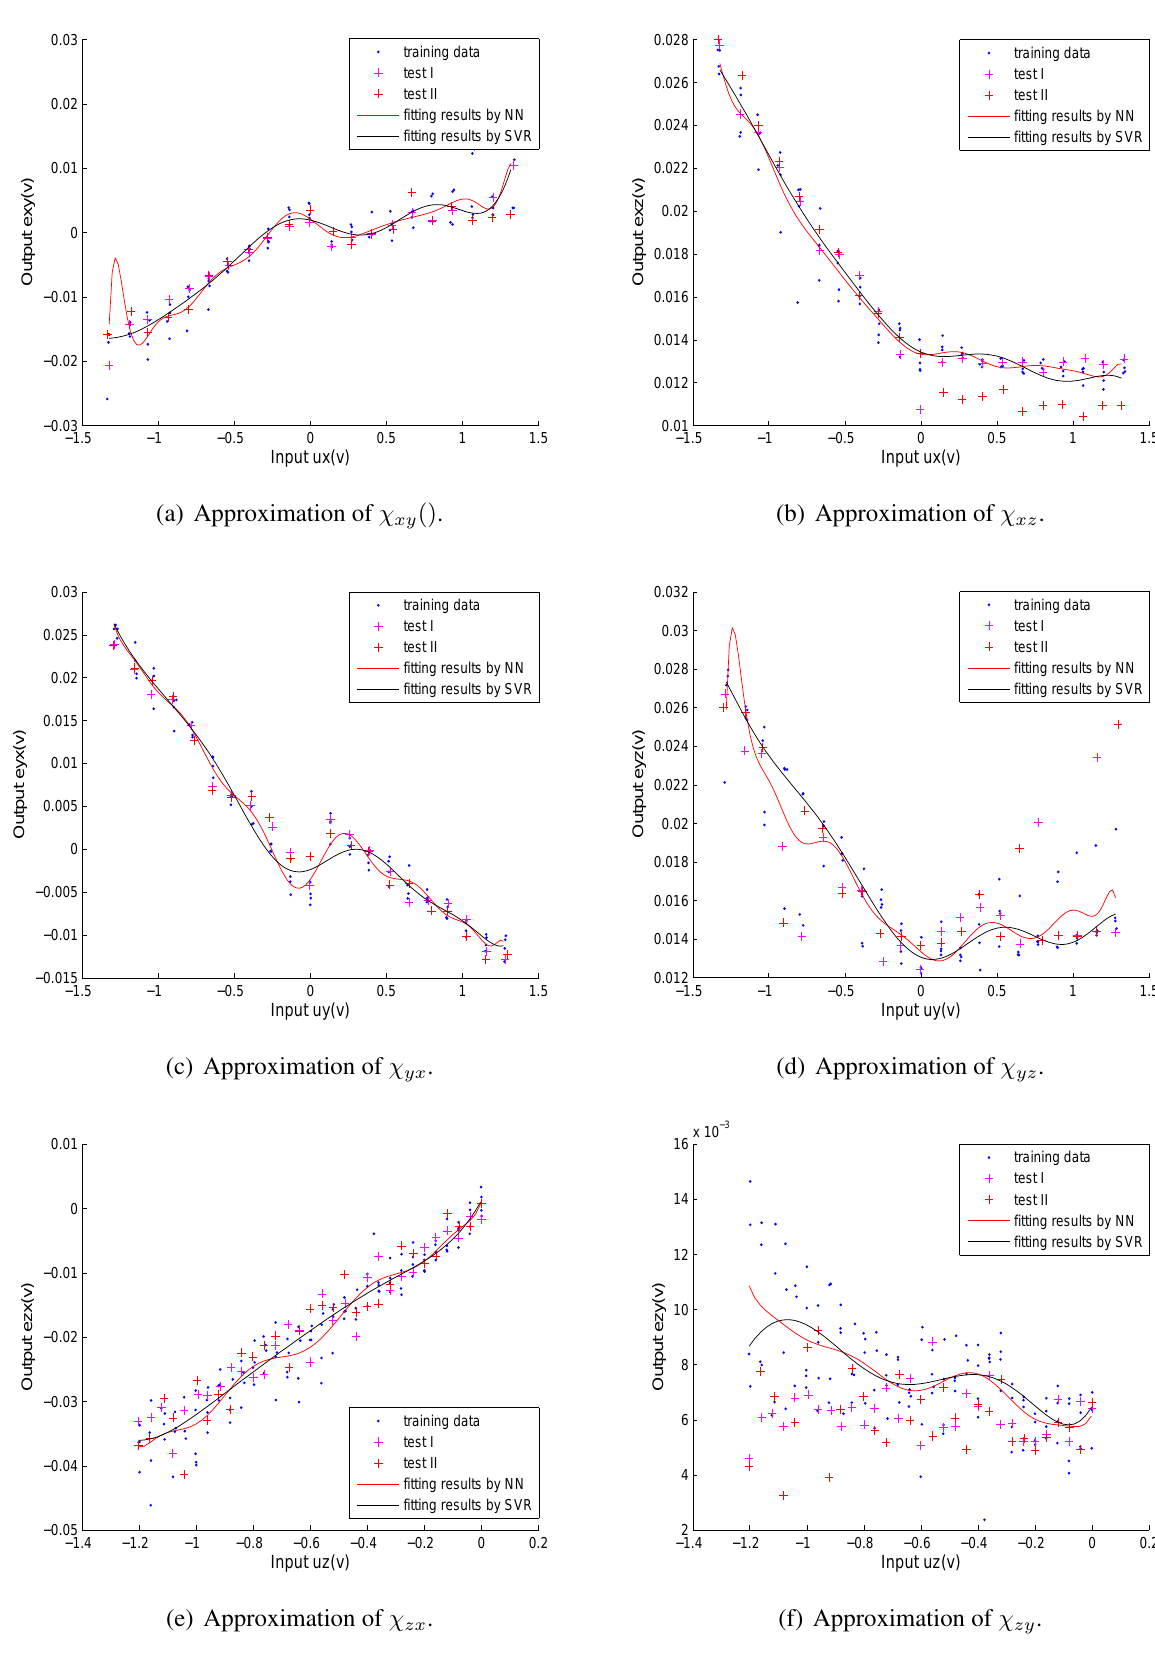
Figure 7. Approximation of corrected coupling functions by (cid:15) -SVR vs. by RBF